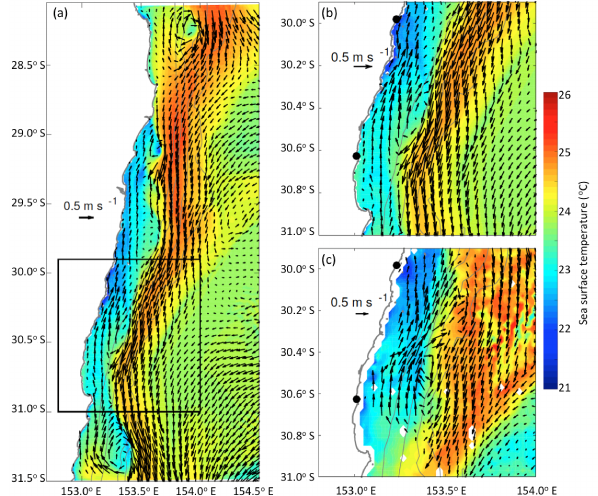
Figure 6. Snapshots of (a, b) modelled and (c) observed surface ve- locity and SST for 15 May 2012. Model results are from a 1km res- olution WebMARVL-configured ROMS run off southeastern Aus- tralia (Fig. 4), and observations are from 6-day composite satellite Advanced Very High Resolution Radiometer (AVHRR) SST and land-based HF radar measurements (the location of the HF radar sites are shown by black dot in b and c ). The coastline and 100, 200, 1000, 2000, and 5000m isobaths are shown in grey. For clar- ity, velocity vectors are only plotted every fifth grid point in (a) , every fourth grid point in (b) , and every third point for the HF radar data in (c)